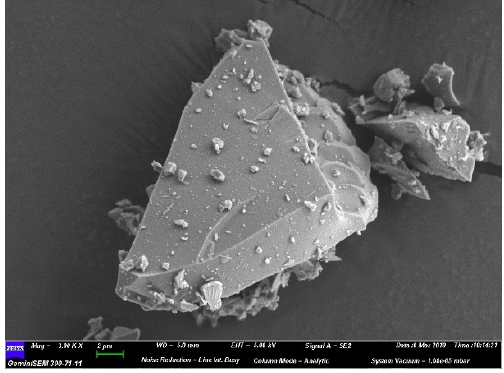
Figure 2. Morphology of slag particles.